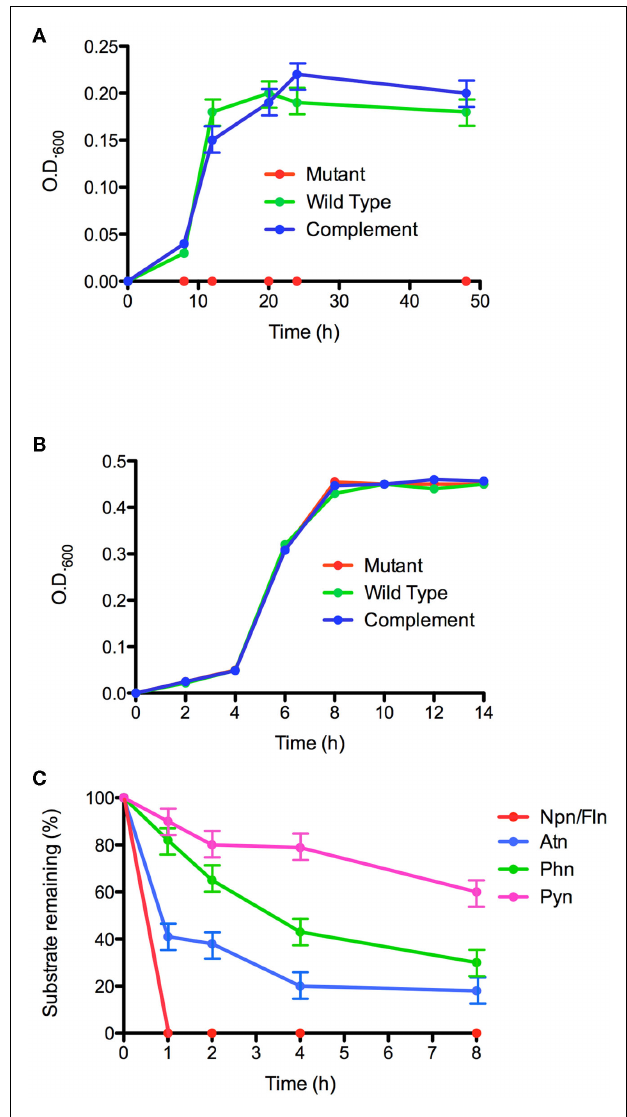
FIGURE 7 | Functional analyses of the phn RHD genes. Growth on phenanthrene (A) and pyruvate (B) by Delftia sp. Cs1-4 wild type (wild type), Δ phnAcAd:Km mutant (mutant), and mutant complemented with phnAcAd (complement). (C) Heterologous expression in E. coli of phnAaAbAcAd and transformation of: naphthalene (Npn), fluorene (Fln), phenanthrene (Phn), anthracene (Atn), and pyrene (Pyn). Data points are the means of three biological replicates; error bars are the